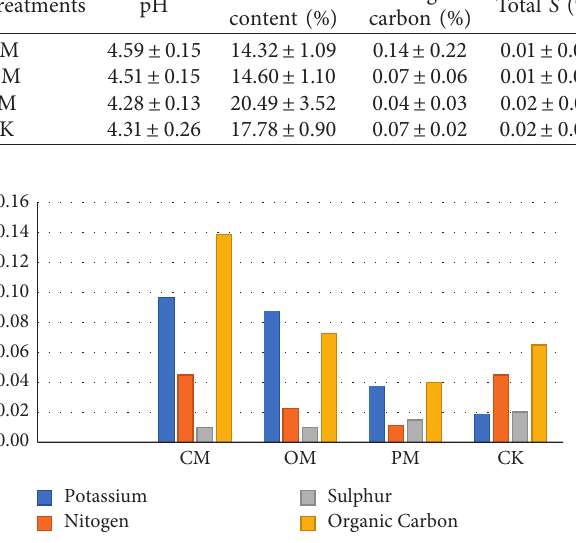
Table 2: Physical and chemical properties of soil under different types of mulching experiments. Treatments